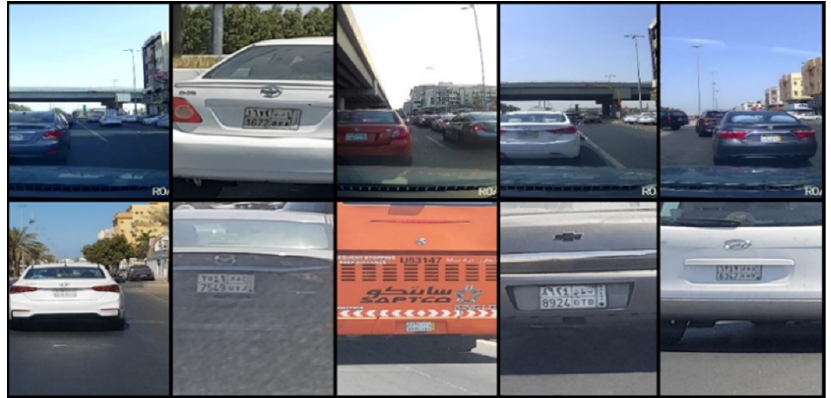
Figure 19. LPs captured from the moving traffic.